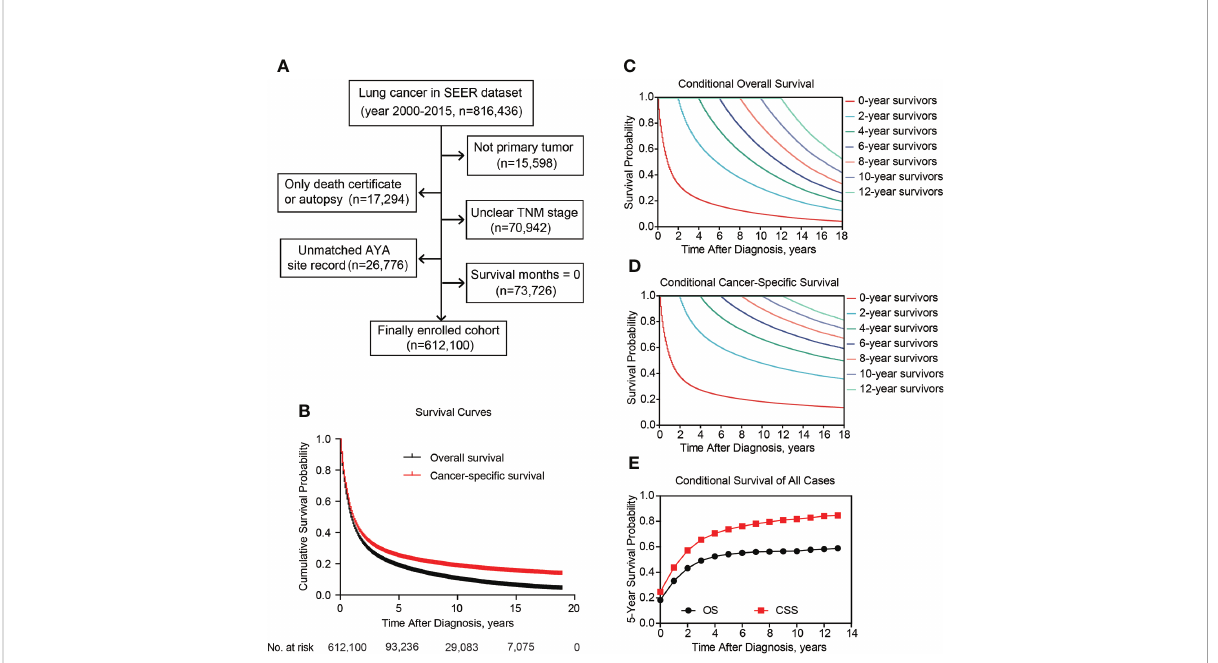
FIGURE 1 Patient inclusion and survival of lung cancer patients. Patients inclusion and exclusion fl ow (A) . Overall and cancer-speci fi c survival of all included cases (B) . Overall (C) and cancer-speci fi c (D) conditional survival of lung cancer patients with Kaplan-Meier analysis. (E) , The 5-year overall and cancer-speci fi c conditional survival rate of enrolled